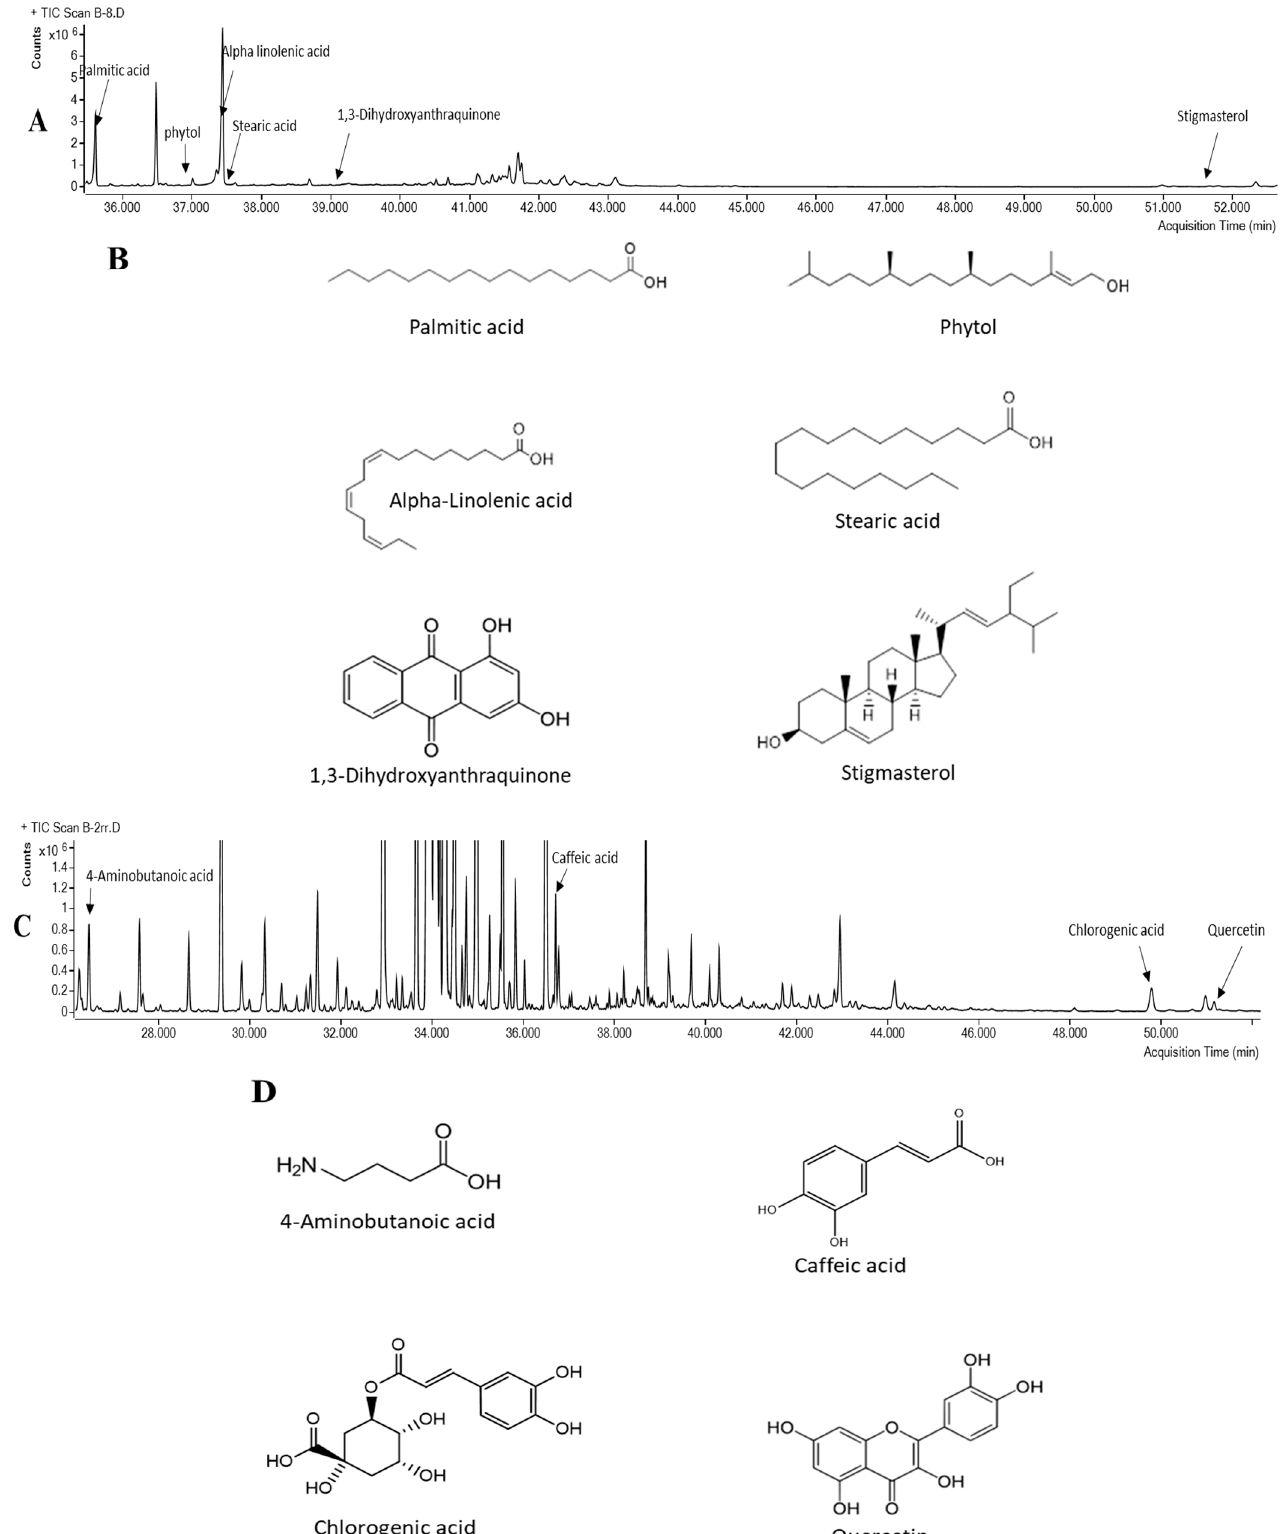
Figure 5. Total ion chromatogram (TIC) of O. stamineus methanol ( A ) and water ( C ) extract. Chemical structure of the identified antidiabetic components in O. stamineus methanol and water extract is depicted in ( B ) and ( D ), respectively.